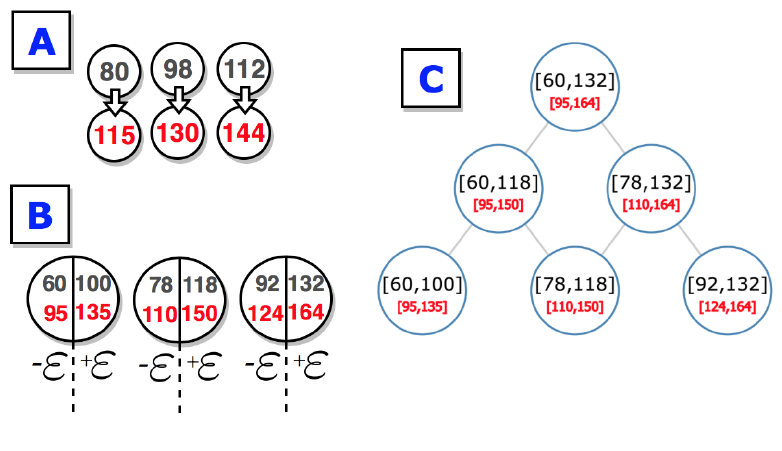
Figure 6. Process to create the tree. Sub-Figure A represents raw data. Sub-Figure B represents data after being transformed into intervals. Sub-Figure C shows the tree after being built by the